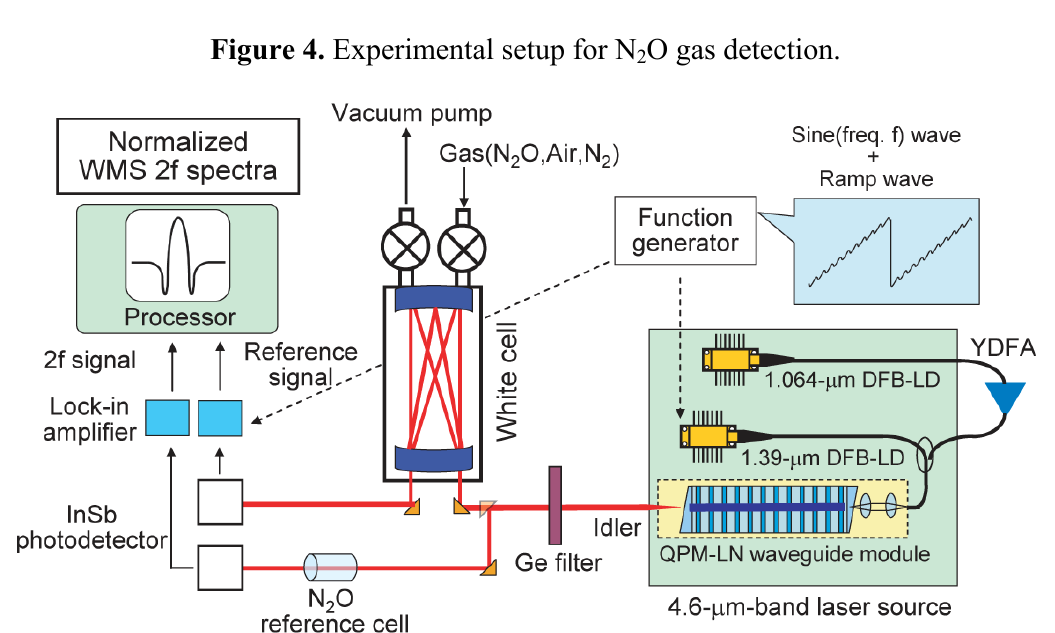
Figure 4. Experimental setup for N